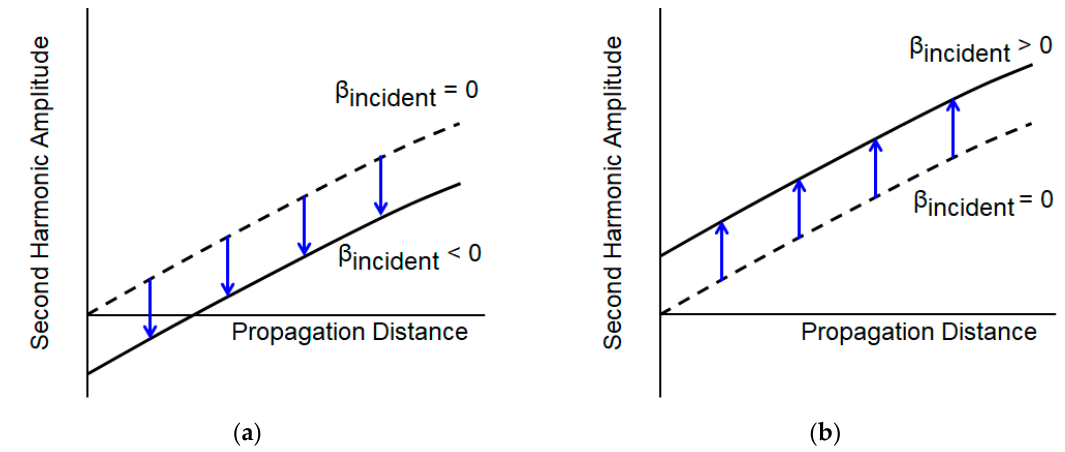
Figure 6. The trend of the second harmonic amplitude according to the propagation distance when the incident second harmonic wave exists in ( a ) fused silica and ( b )